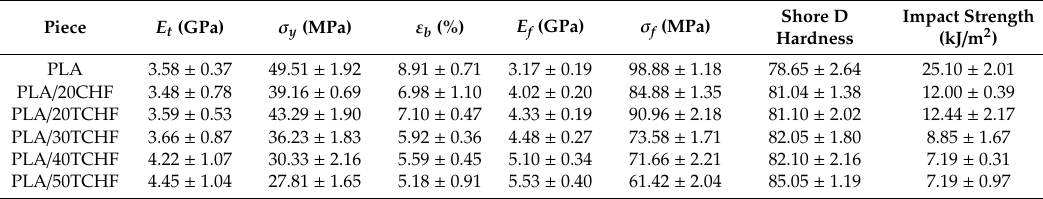
Table 2. Mechanical properties of the injection-molded pieces of polylactide (PLA) with co ff ee husk flour (CHF) and torrefied co ff ee husk flour (TCHF) in terms of tensile modulus ( E t ), tensile stress at yield ( σ y ), elongation at break ( ε b ), maximum flexural stress ( σ f ), flexural modulus ( E f ), Shore D hardness, and impact